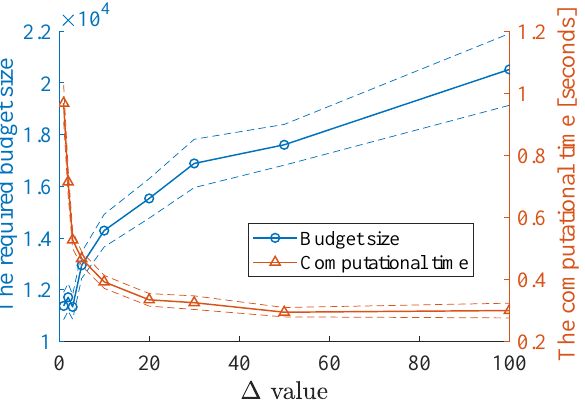
Figure 6. The average total budget size and the average computational time required to obtain all optima in Problem F6 ( 3,3,3 ) . A total of 100 replications are